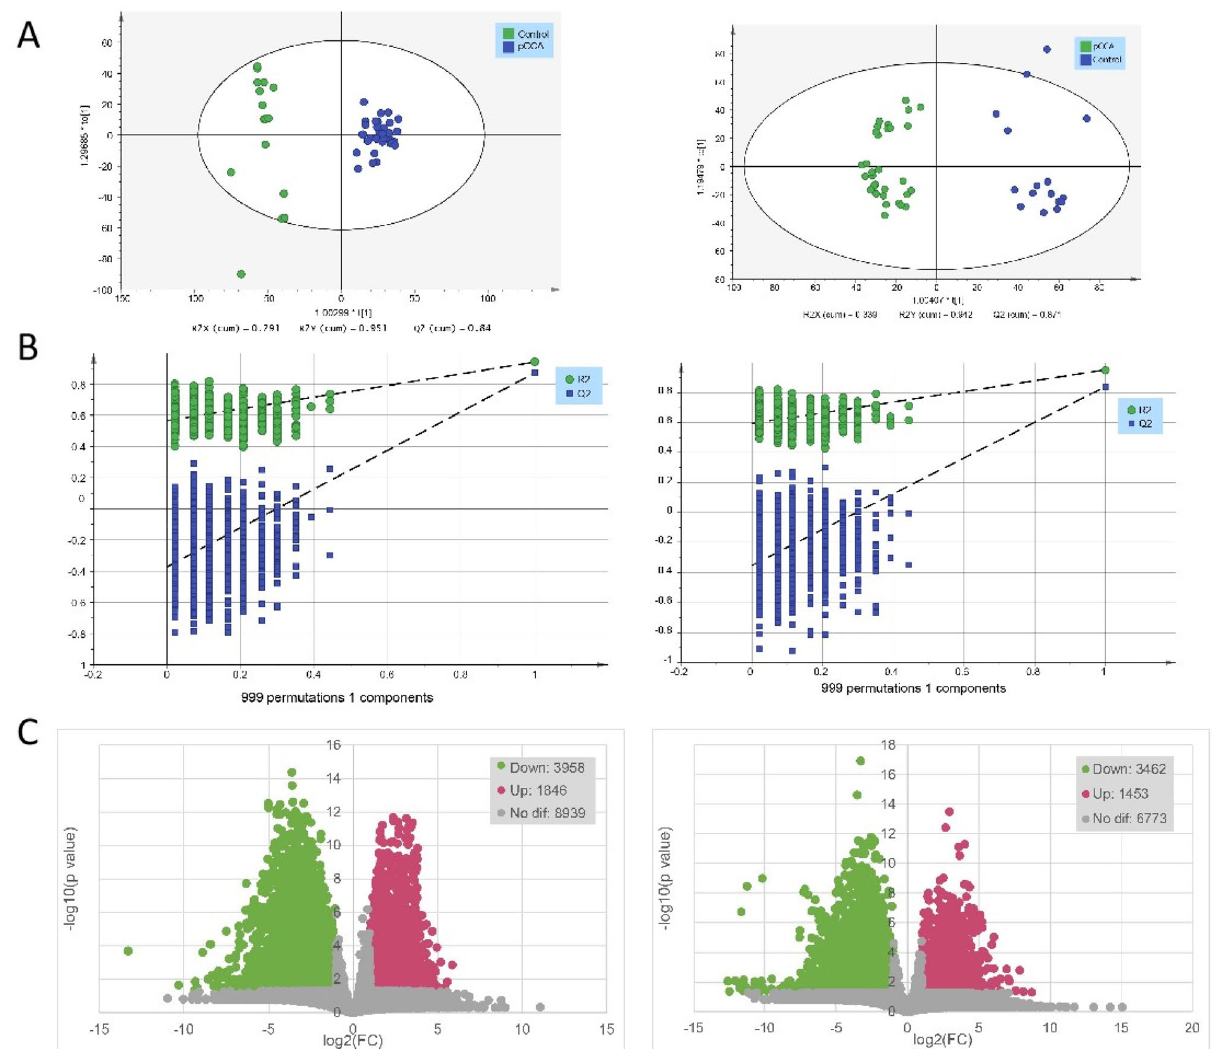
R2Y and Q2 values of the model, and the remaining points were the R2Y and Q2 values obtained after the samples were randomly arranged. All predicted values are lower than true values, indicating that the model is true and effective. ( C ) Volcanic map of differential metabolites [p ≤ 0.05, |log2(pCCA/Control)| ≥ 1 considered to be differential]. Blue was the down-regulated differential metabolite, red was the up-regulated differential metabolite, and metabolites with no difference were marked as